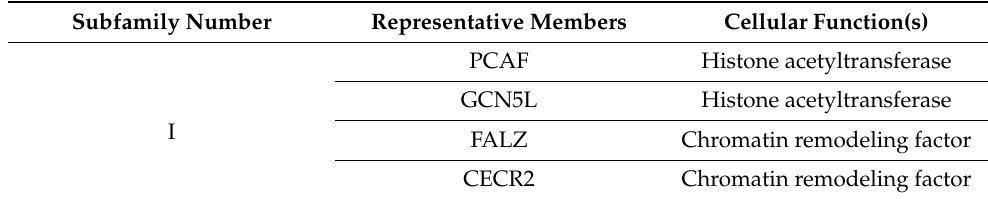
Table 1. The eight subfamilies of bromodomain (BRD)-containing proteins encoded in the human